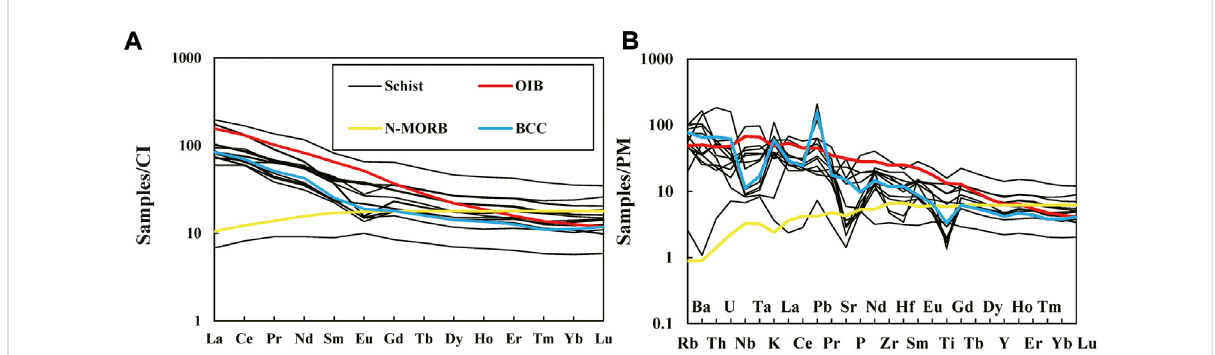
FIGURE 7 (A) Chondrite-normalized rare earth element distribution of schist; (B) primitive mantle-normalized trace element spider diagram of schist. BCC- bulk continental crust; OIB- oceanic island basalt; N-MORB- normal mid-ocean ridge basalt. Chondrite, primitive mantle, N-MORB, and OIB data are from Sun and Macdonough (1989), and BCC data are from Rudnick and Gao